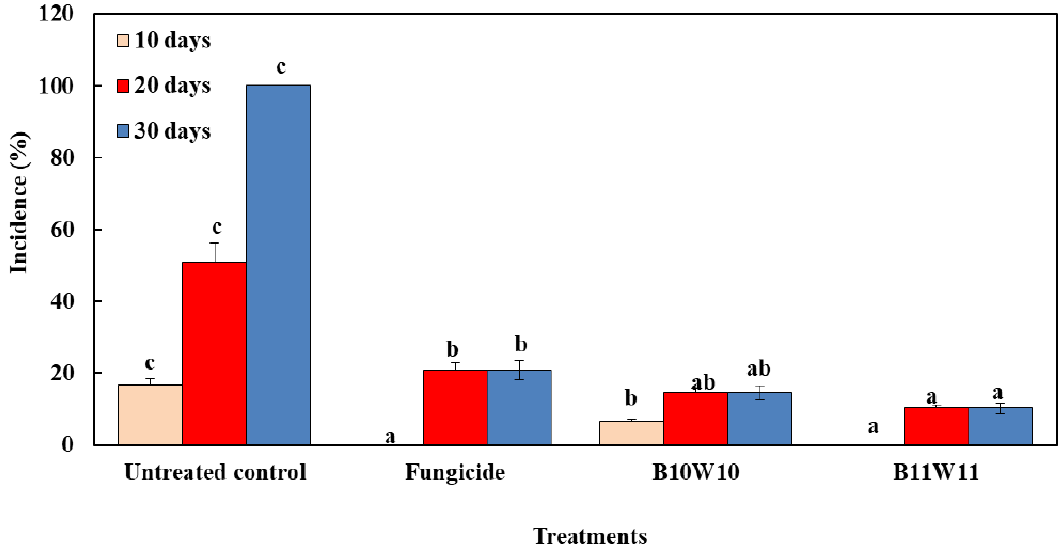
Figure 5. Incidence of brown rot disease observed on apple fruits treated by two selected e ff ective bacterial antagonists ( Bacillus amyloliquefaciens B10W10 and Pseudomonas sp. B11W11) and infected by M. fructigena at 1 × 10 3 spores / mL for di ff erent treatments, after incubation at 24 ◦ C for 10, 20 and 30 days. Data in the figure represent the mean of two trials conducted over time with three replicates per treatment (10 apple fruits / replicate). For each incubation period, treatment having the same letter are not significantly di ff erent according to the LSD test ( p < 0.05).